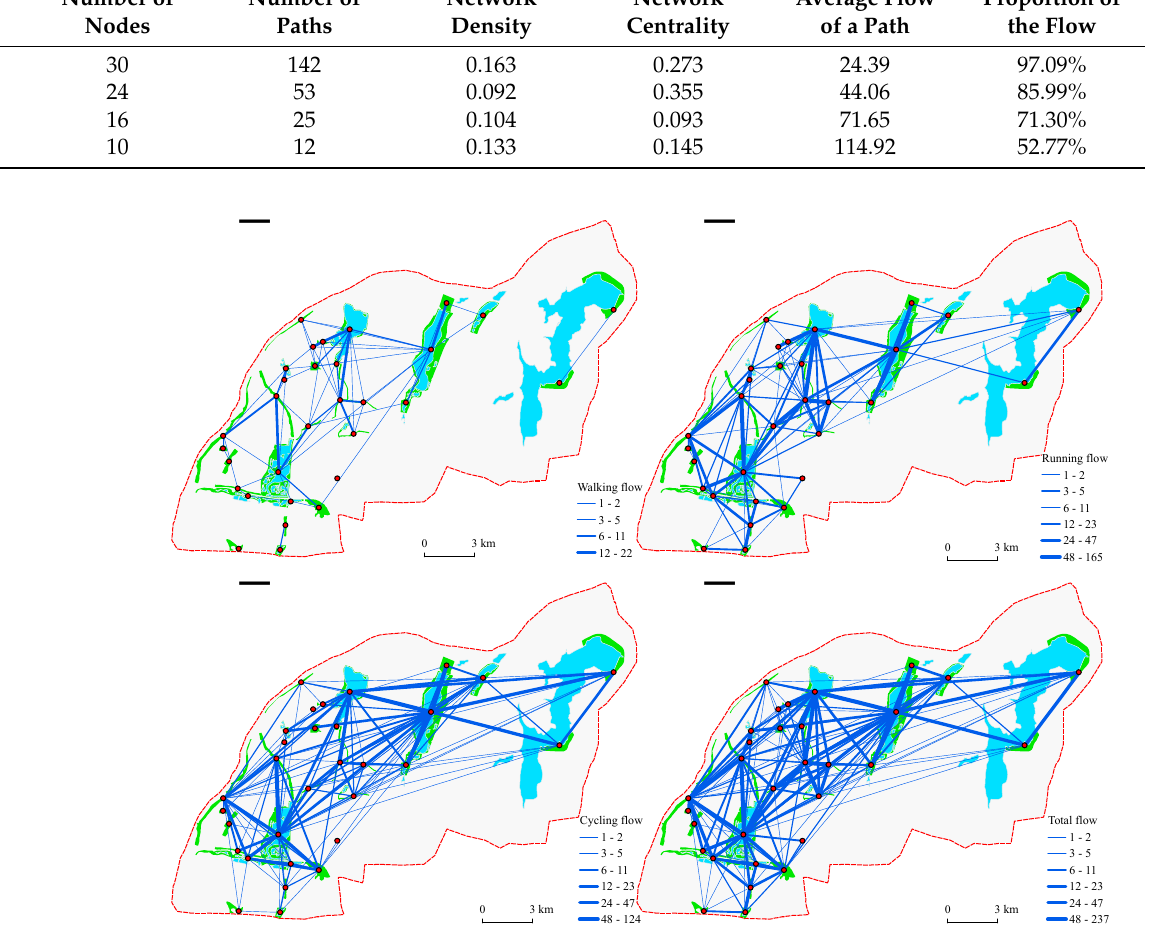
Figure 4. Flow networks under different exercise types.